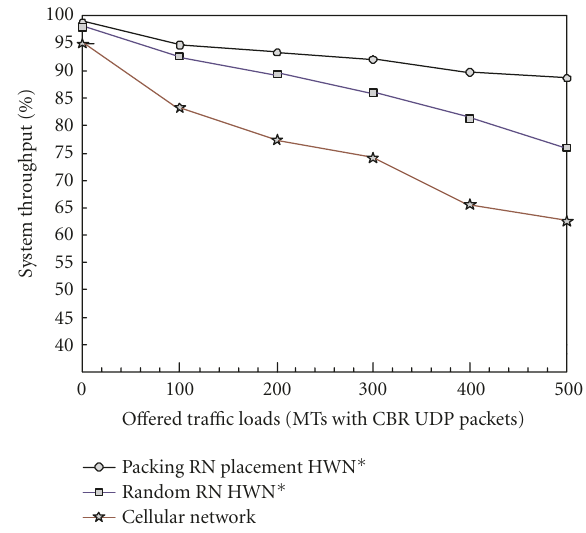
Figure 9: Packing RN HWN ∗ , random RN HWN ∗ , and cellular network throughput versus o ff ered